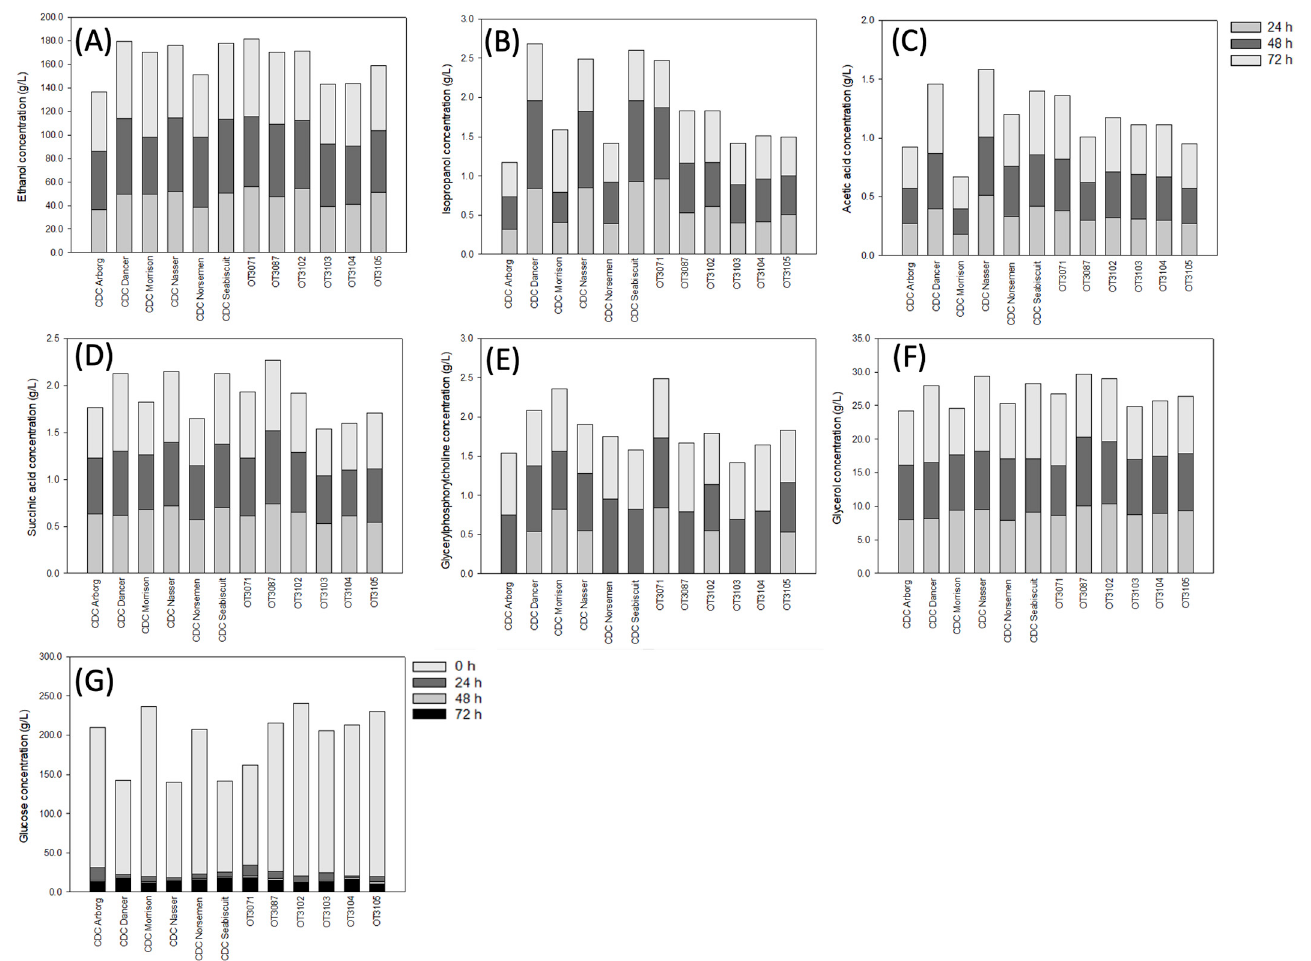
Figure 2. Concentration of ethanol ( A ), isopropanol ( B ), acetic acid ( C ), succinic acid ( D ), α -glycerylphosphorylcholine ( E ), glycerol ( F ) and glucose ( G ) in mash sampled every 24 h during yeast fermentation of different oat cultivars.